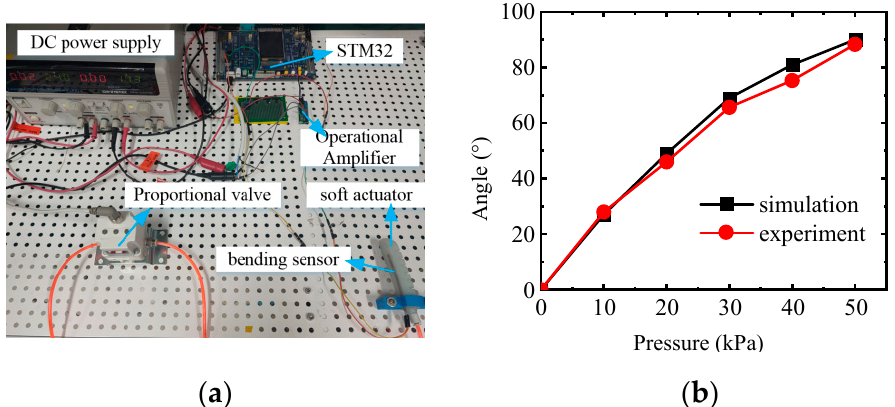
Figure 13. Bending angle test of bending actuator. ( a ) Bending Actuator Test Platform and ( b ) Bending Characteristics of Bending Actuators.